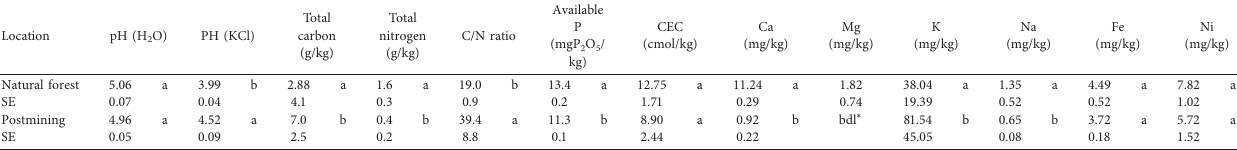
Table 1: Chemical characteristics of the soils from the natural forests and post bauxite mining